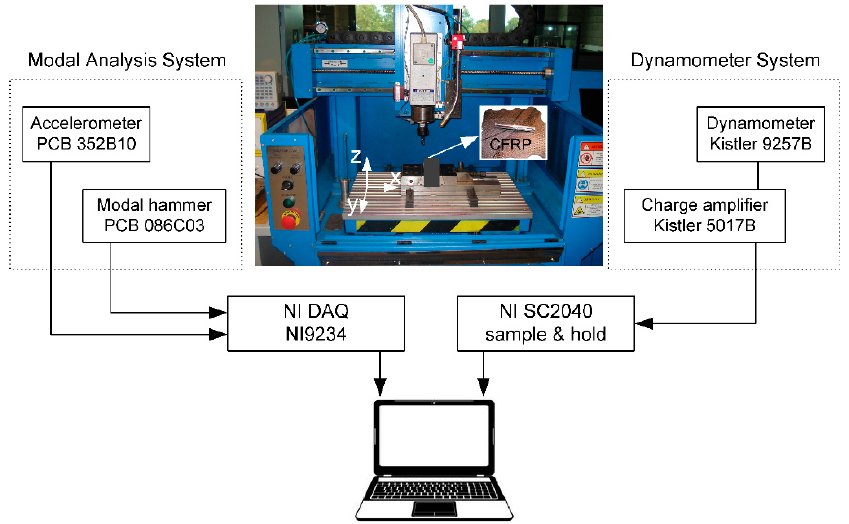
Figure 1. Scheme of experimental setup consisting of milling machine, modal analysis system and dynamometer system.